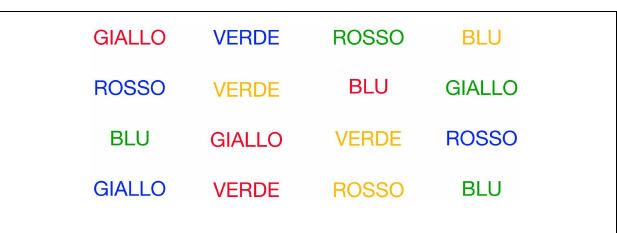
FIGURE 4 | Naming With Interference